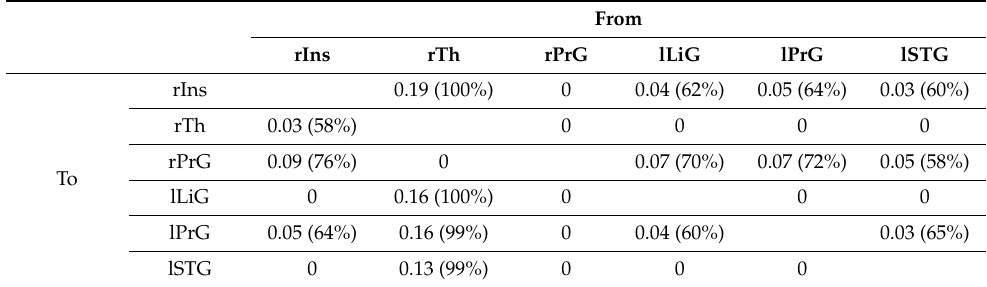
r: right hemisphere/l: left